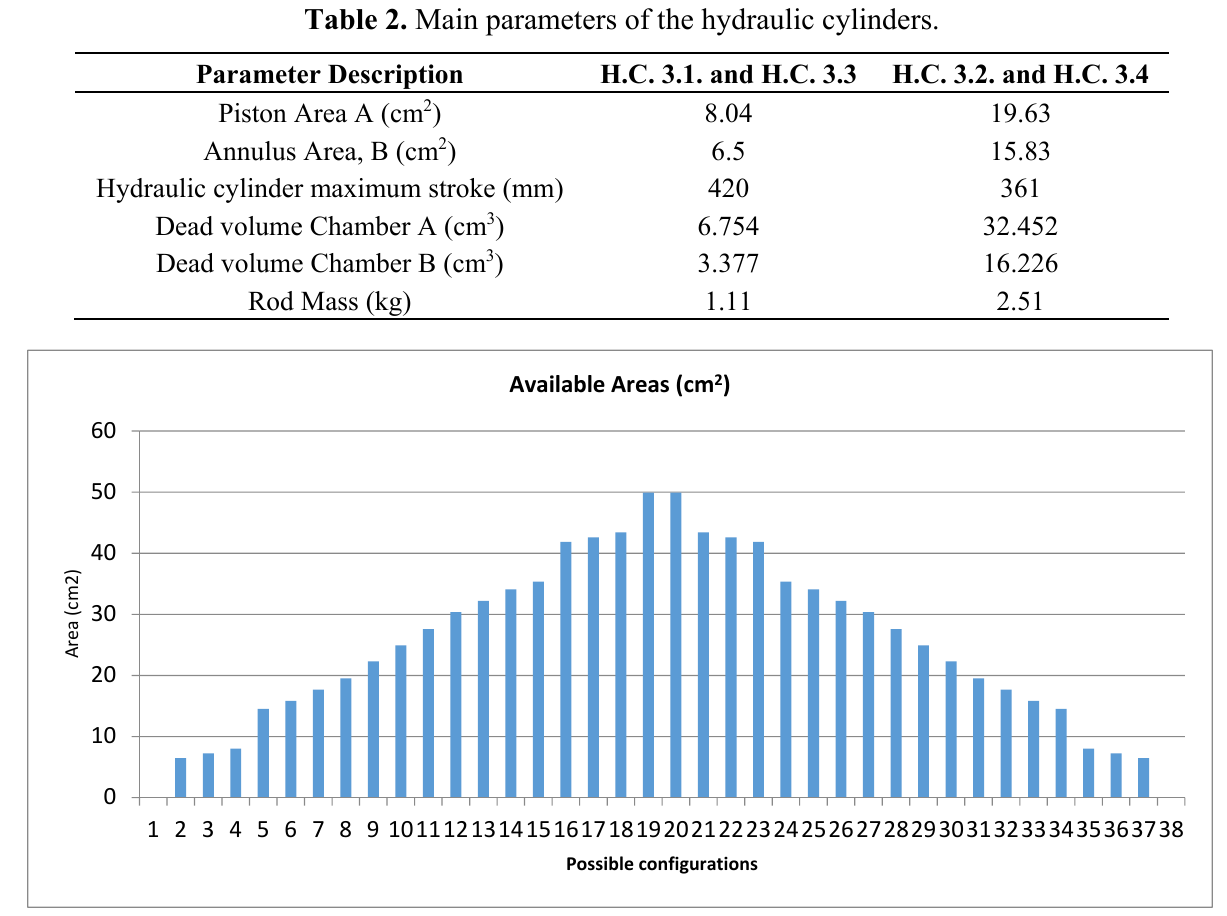
Figure 5. Available areas depending on the hydraulic cylinders on